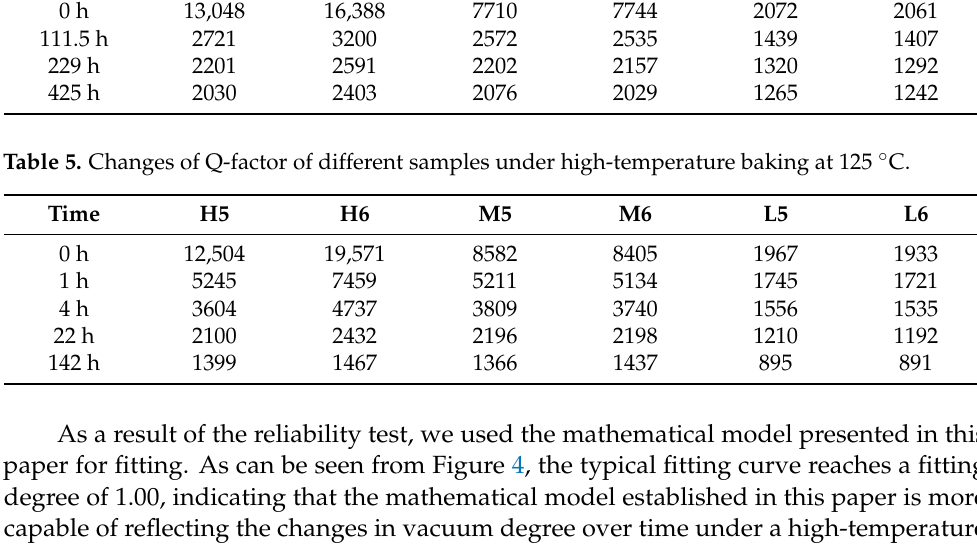
0.97 Table 7. Parameter values of Q-factor degradation fitting curve baking at 105 °C. Sample 1.00 Table 8. Parameter values of Q-factor degradation fitting curve baking at 125 °C. Sample